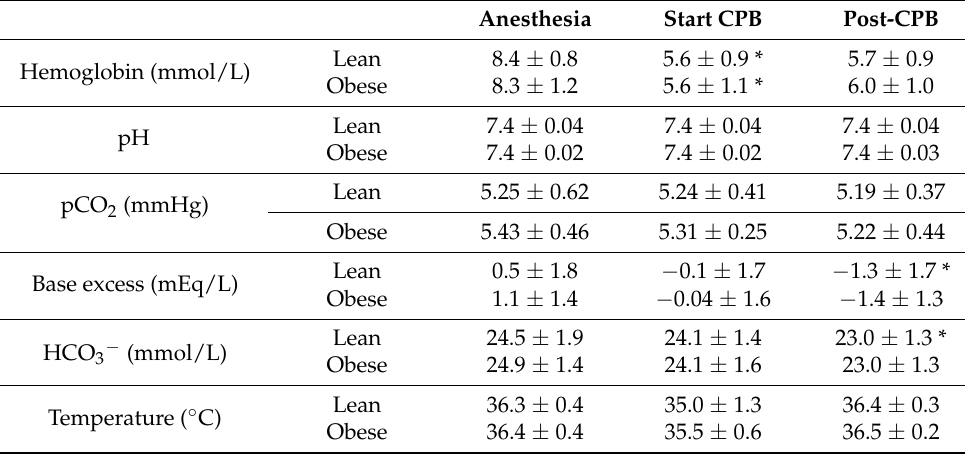
Table 2. Intraoperative hemoglobin, temperature, and blood gas values.